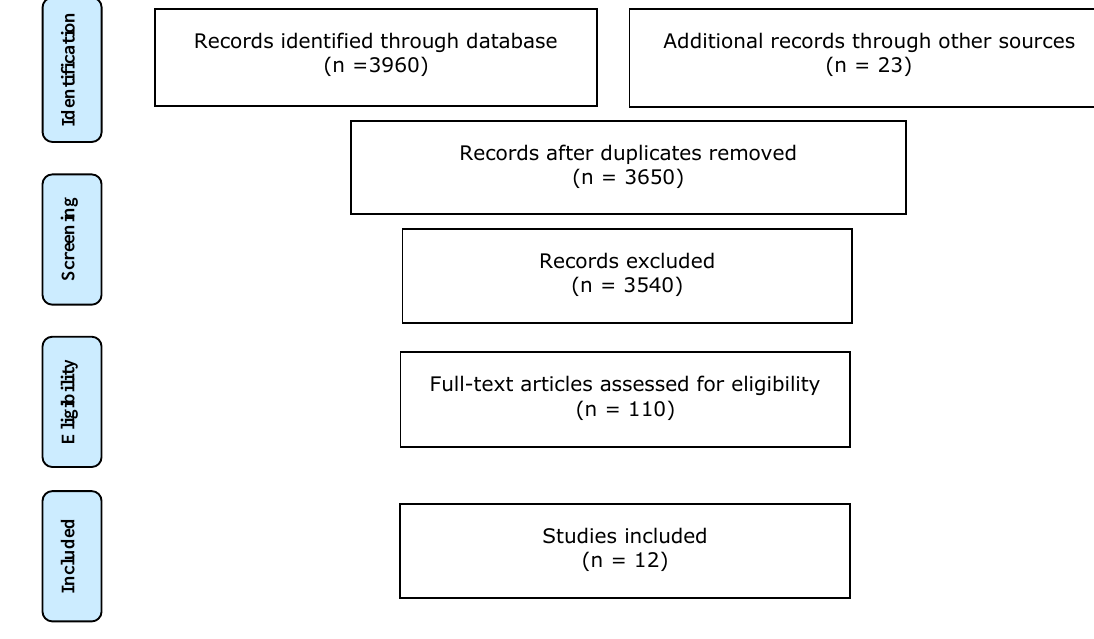
Studies included (n =